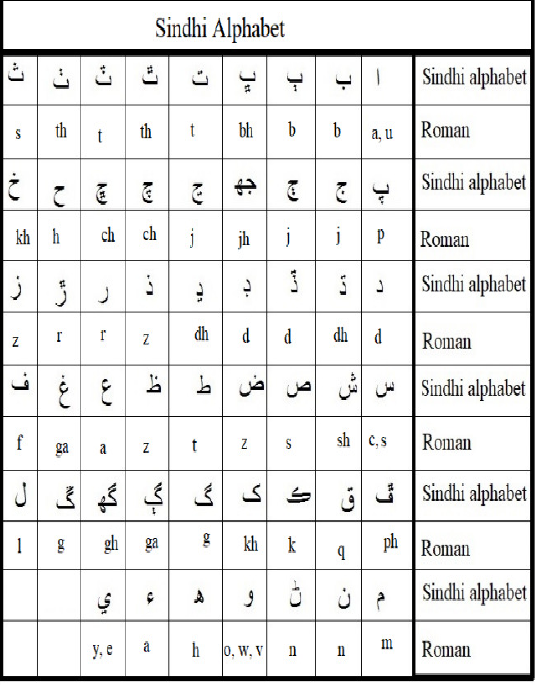
Fig. 1: Sindhi-Roman Alphabet 3.2 Romanized Sindhi